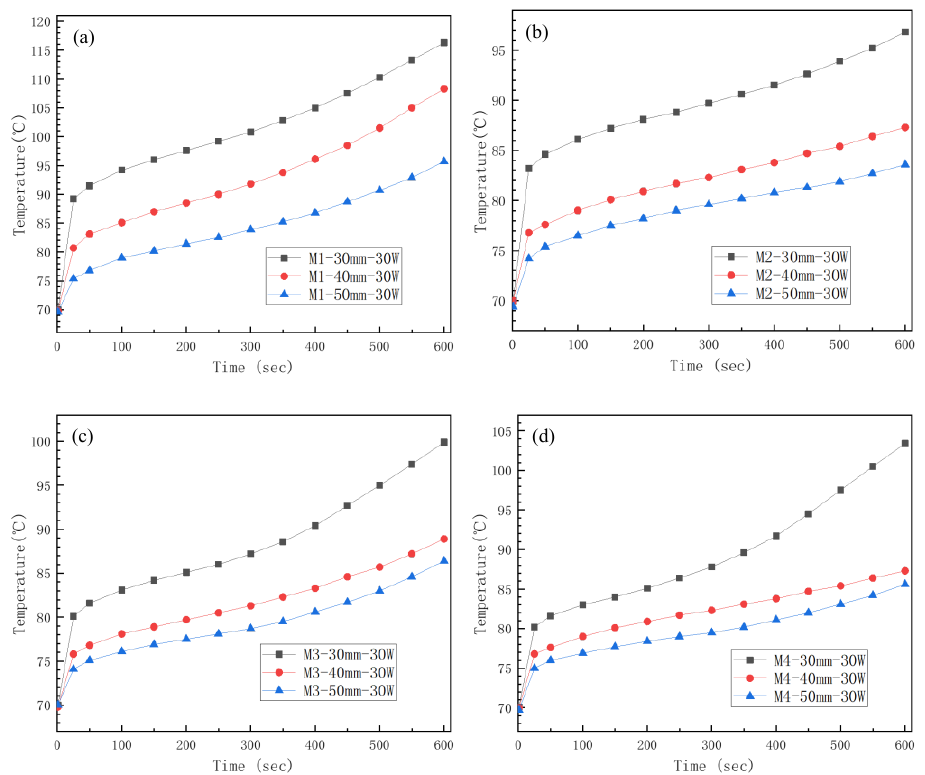
Figure 8. Performance of each phase change module under 30 W with different heat source sizes: ( a ) module 1, ( b ) module 2, ( c ) module 3, ( d ) module 4.